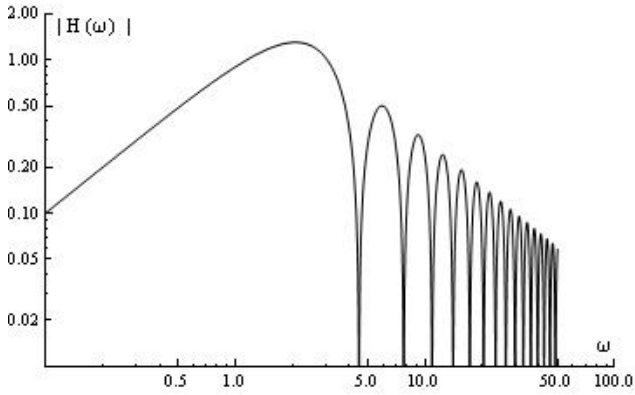
Figure 2. Modulus of the frequency response of the first order Legendre derivative.